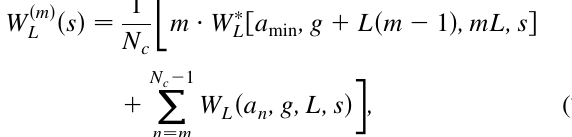
FIG. 6. Short-range longitudinal wake functions were calcu- lated using the KB* model in the periodic structures (dashed lines): first cell (black), last cell (blue), and last iris spaced by LN (red); and using different models for the tapered structure c (solid lines): h KB i (red), M0 (black), M1